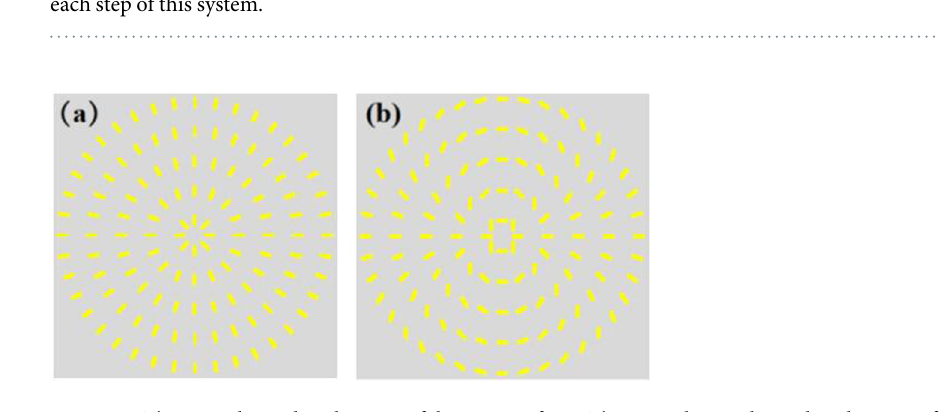
in the lower left corner of Fig. 1(a). Through using combination of Glan laser polarizer (GL) and quarter-wave plate (QWP) to generate LCP or RCP. The general intensity profiles of the output light beams (VB) present a doughnut shape. From Fig. 3(a) we can see that, with the increase of the topological charge, the radius of the doughnut-shape ring is increasing. And the radius of the doughnut-shape ring for the positive topological charge and negative topological charge is same. In order to measure the wavefront shape and the topological charge of the VB, the beam was utilized to interfere with a plane wave. The process of interference was carried out by combing VB with a plane wave by using a combiner. As shown in Fig. 3(b), the number of dislocated interference fringes is equivalent to the topological charge. And when the topological charge is a positive integer, the direction of the fork fringes is oblique upward. Conversely, the direction of the fork fringes is oblique downward. To further investigate the handedness of the output light beam after metasurface, an experimental scheme was carried out as showed in Fig. 4. After the RCP (LCP) Gaussian beam passing through the metasurface with the q-value of 1, the LCP (RCP) VB was obtained. It is known that a QWP whose fast axis was rotated to + 45° can be utilized to transform the LCP (RCP) into horizontal (vertical) polarization. The combination of QWP whose fast